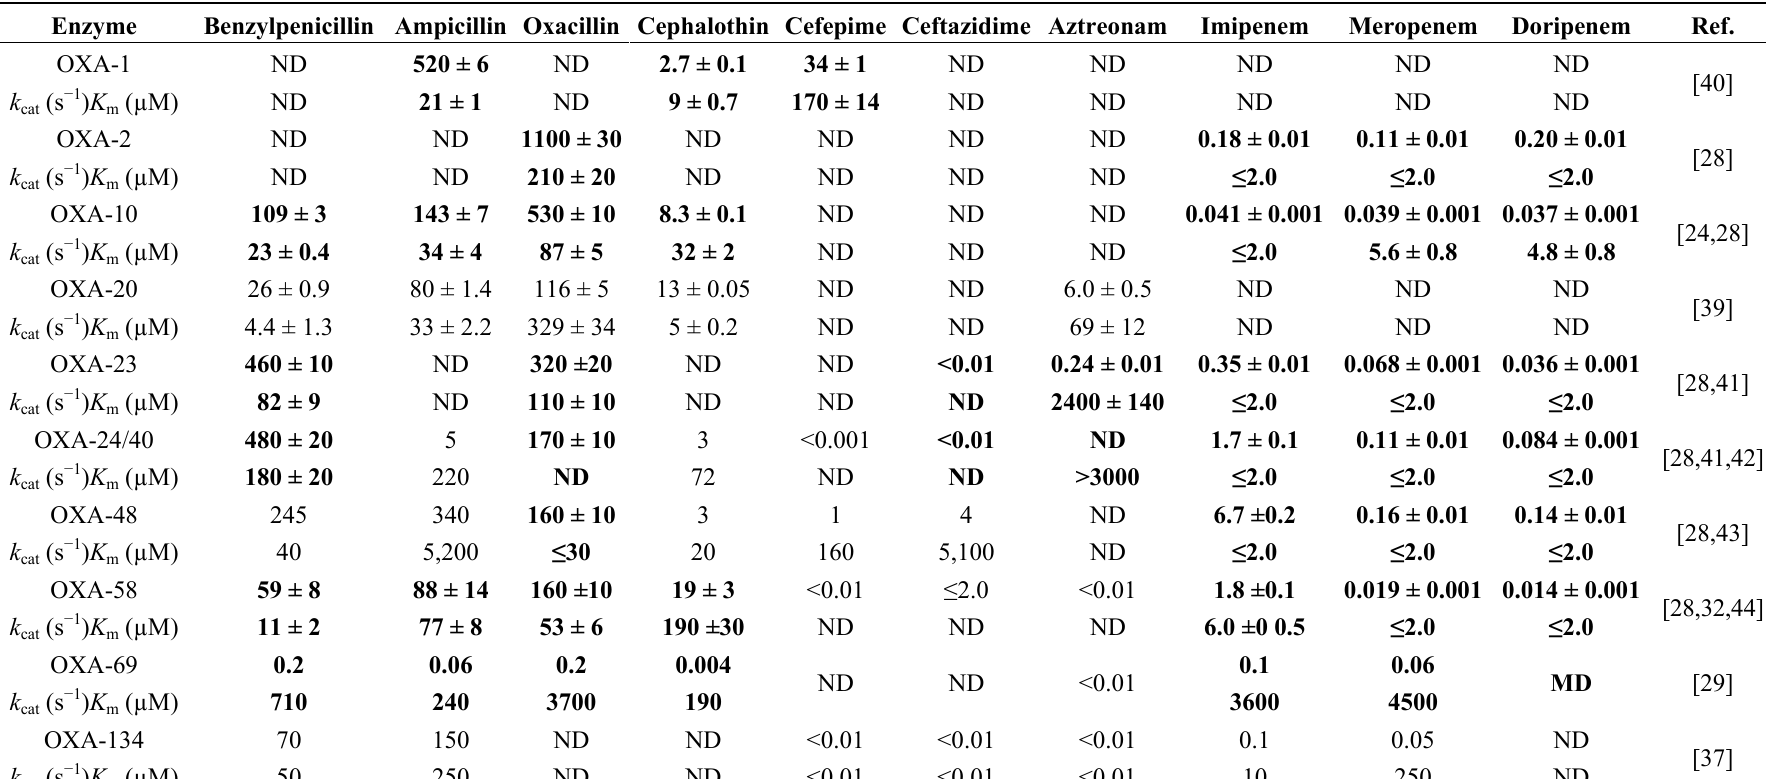
Table 3. Kinetic values of several Class D β-lactamases against representative β-lactam